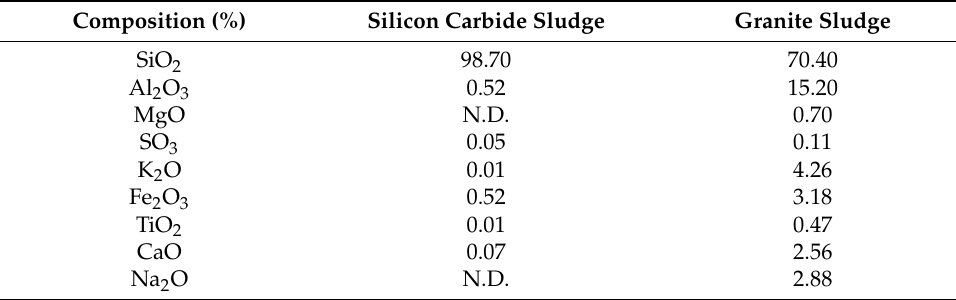
Figure 1. Particle size distribution of SiC sludge and GS.